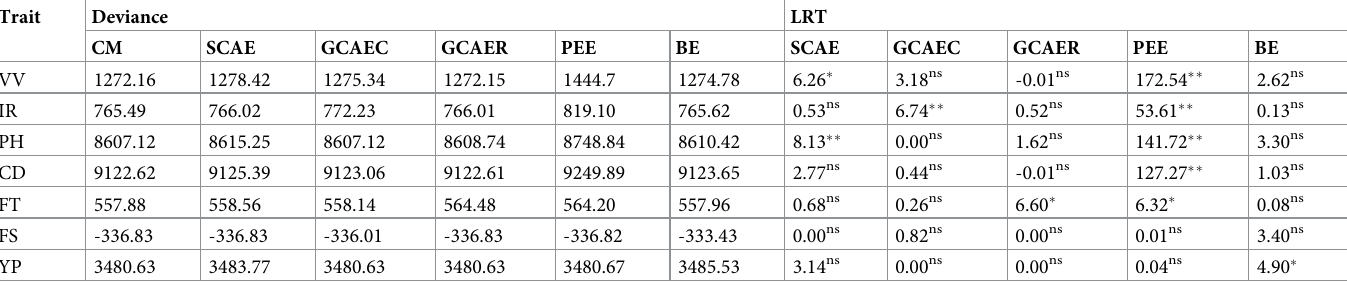
Table 7. Deviance and likelihood ratio test (LRT) for the following traits: Vegetative vigor (VV), incidence of rust (IR), plant height (AP), canopy diameter (CD), fruit ripening time (FT), fruit size (FS), and yield per plant (YP), evaluated in the hybrid coffee population. Trait Deviance LRT CM SCAE GCAEC IR 765.49 PH